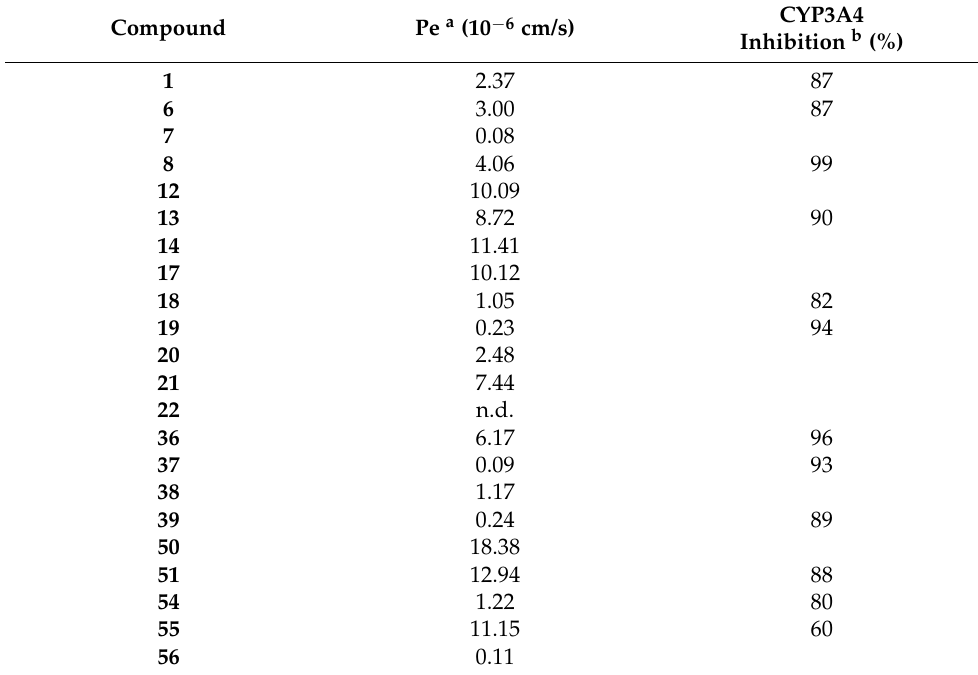
Table 3. Passive permeability and CYP3A4 inhibition values of compounds 1 , 6 – 8 , 12 – 14 , 17 – 22 , 36 – 39 , 50 , 51 and 54 – 56